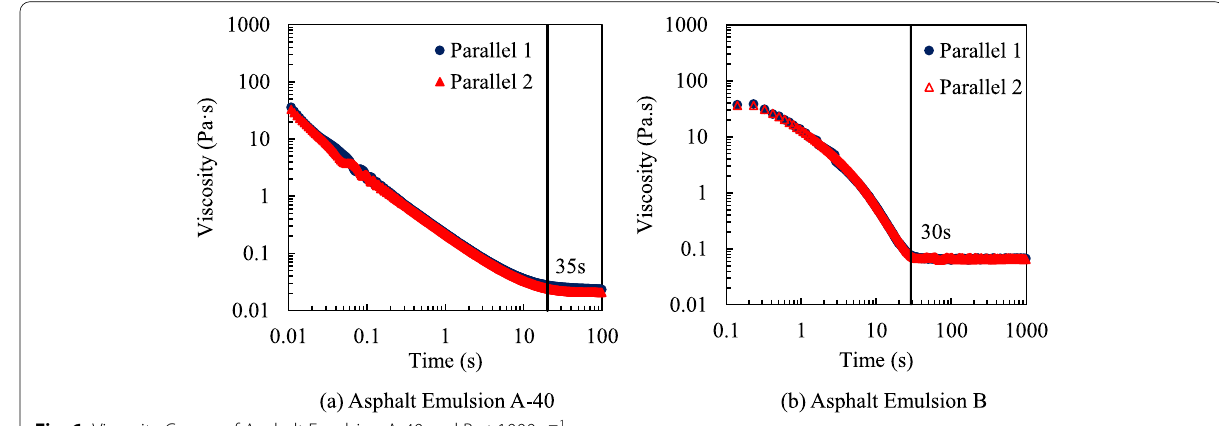
Fig. 6 Viscosity Curves of Asphalt Emulsion A-40 and B at 1000 s − 1